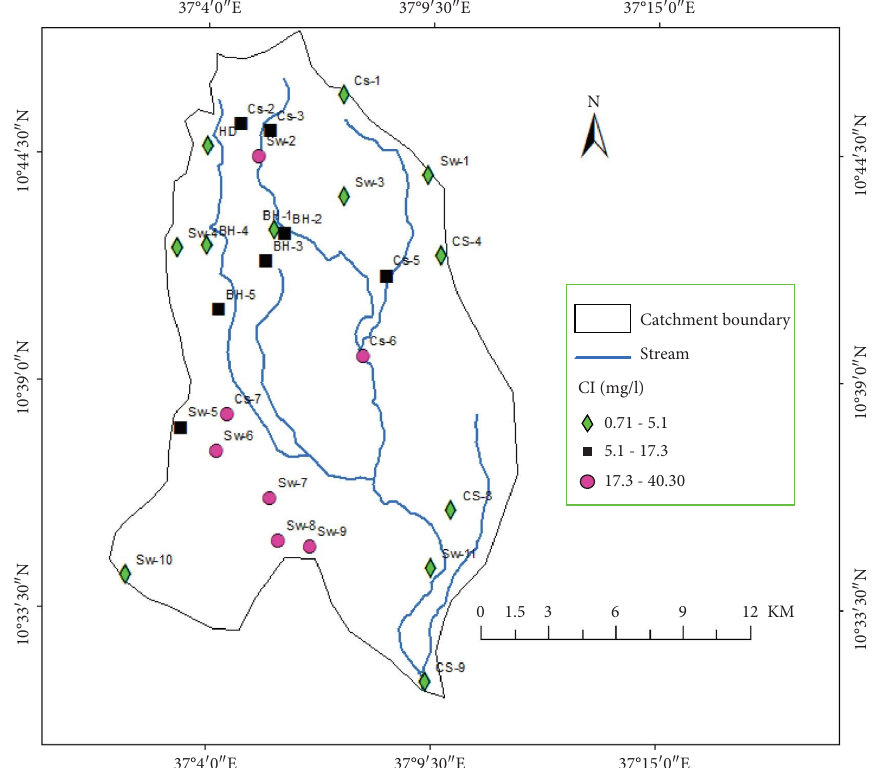
Figure 13: Spatial variability map of